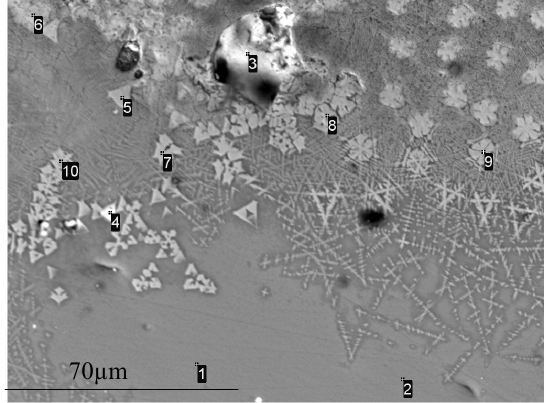
Fig. 4. Microstructure of sample after annealing at 1023 К within 60 min and a point of phases local probing. Table 2. X-ray spectral analysis data: composition